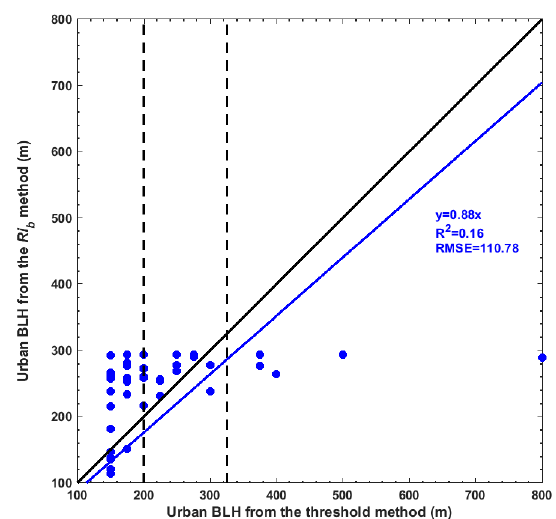
Figure 4. Comparison of the boundary layer depths calculated using Ri b and threshold methods from 1 to 31 December 2016. Dashed lines: 200 m (definition of the onset of the convective boundary layer) and 325 m (the height of the meteorology tower).